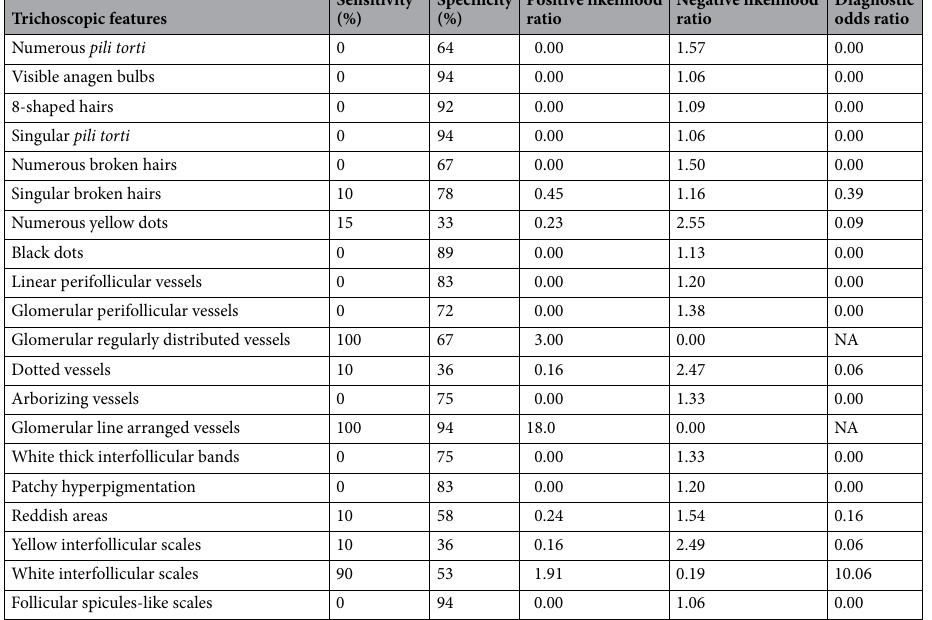
Table 4. Sensitivity, specificity, positive and negative likelihood ratio and diagnostic odd ratio of trichoscopic criteria for erythrodermic psoriasis vs erythrodermic atopic dermatitis and erythrodermic cutaneous T-cell